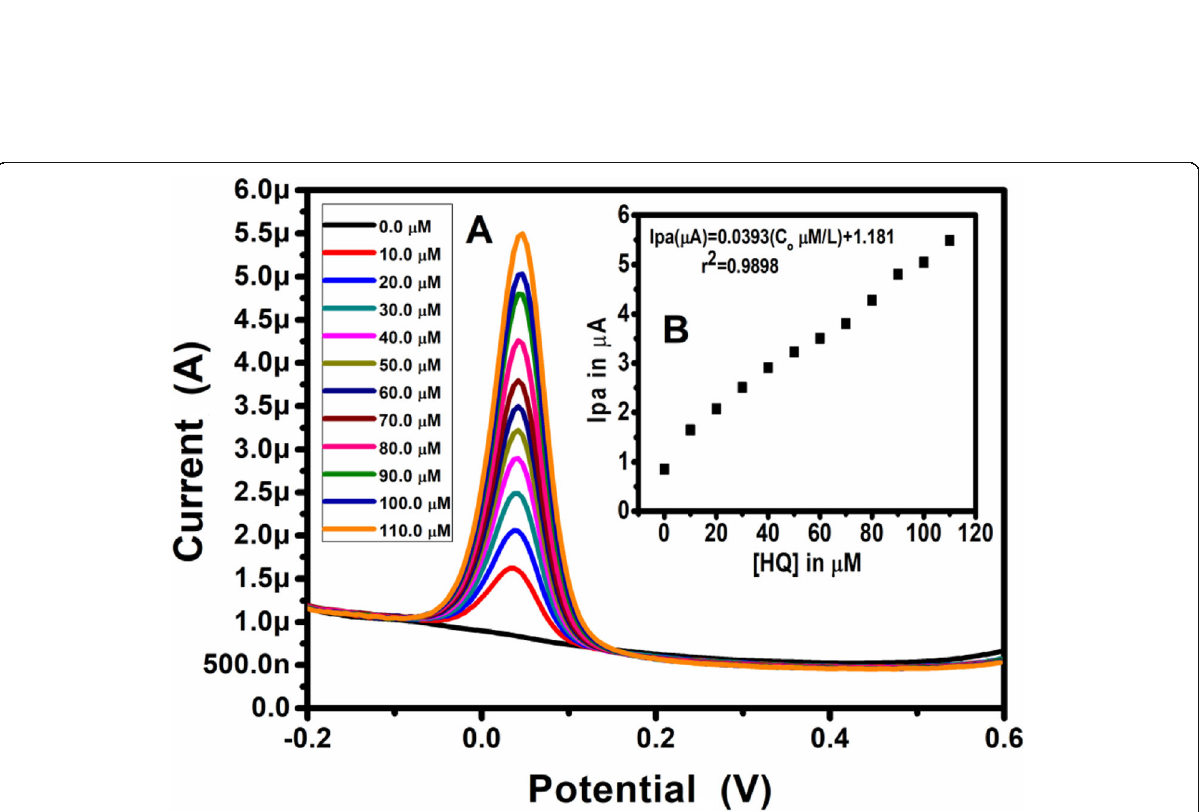
Fig. 8 a DPVs of ALR/GCE with different concentrations of HQ (0 to 110.0 μ M). b Linear plot of Ipa versus concentration of